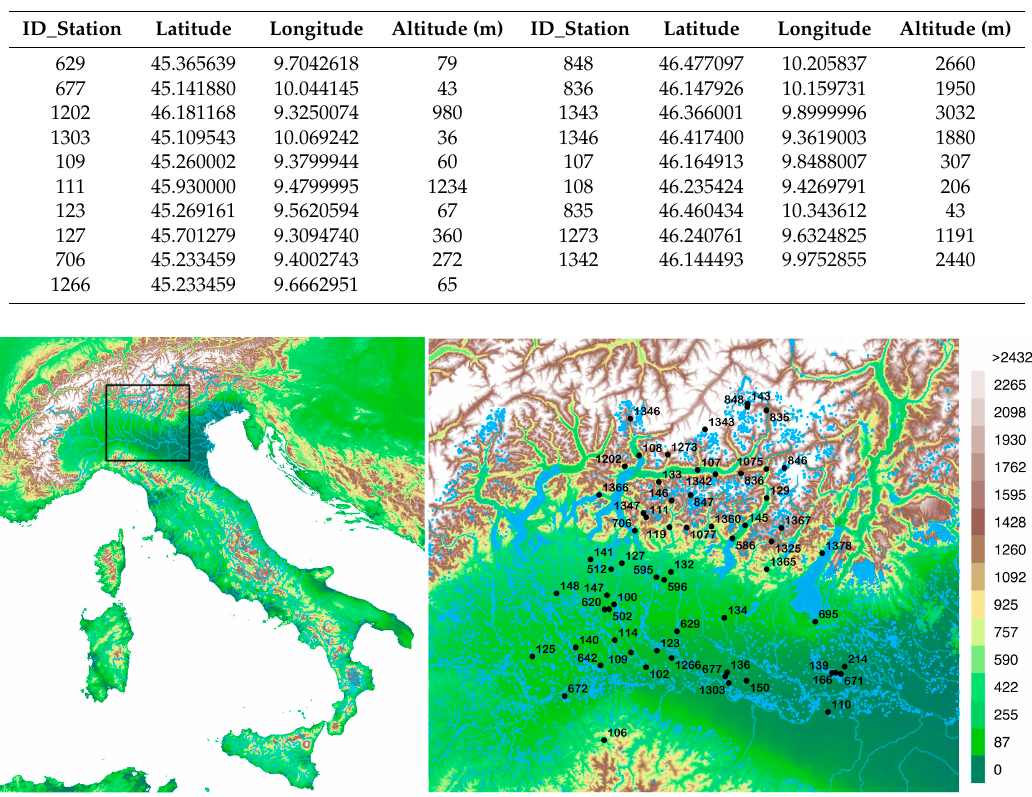
Figure 1. Geographical locations of the used meteorological ground observation stations.